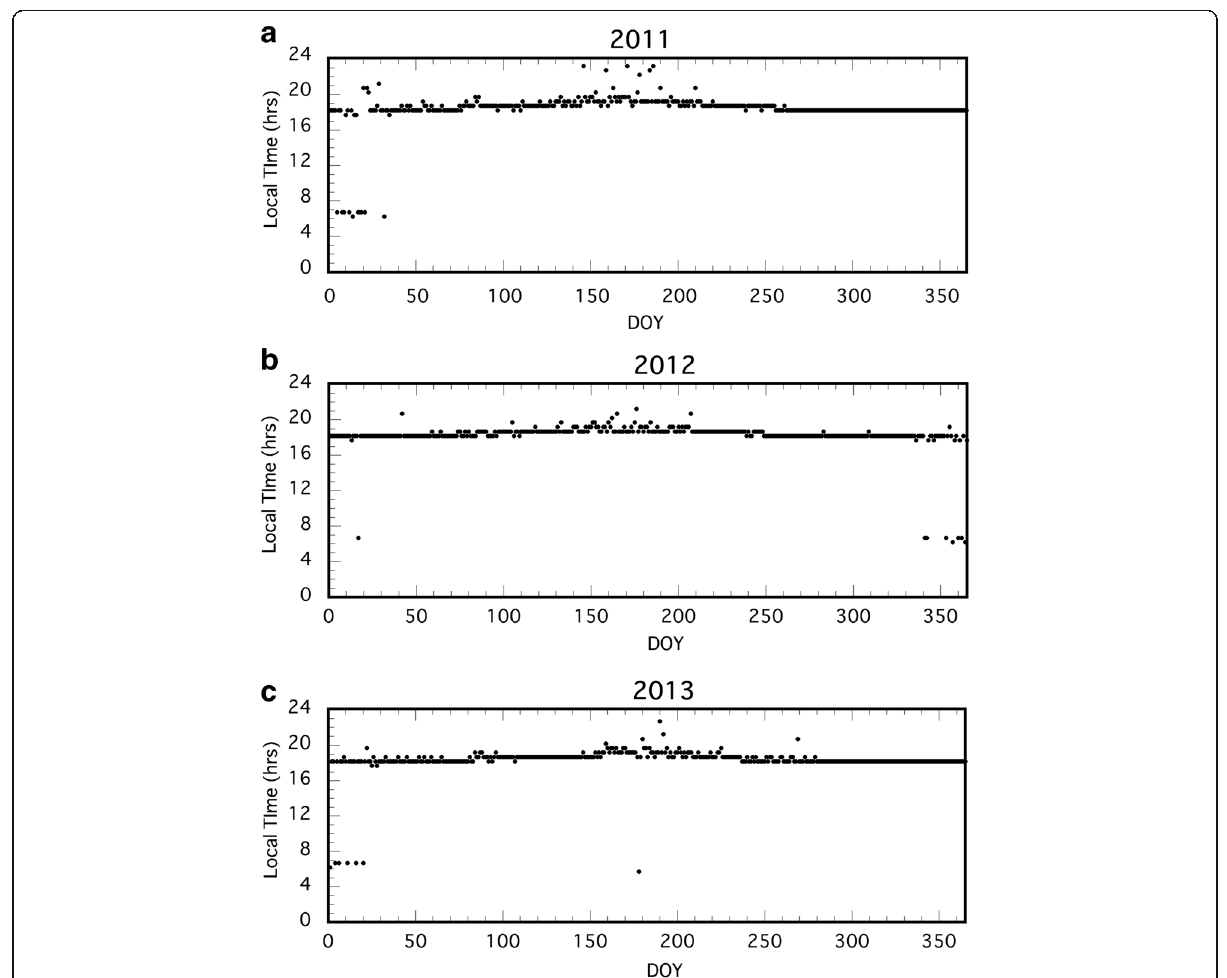
Fig. 6 Local time of the maximum R-T growth rate occurrence. Black circles indicate the local times when the maximum R-T growth rate